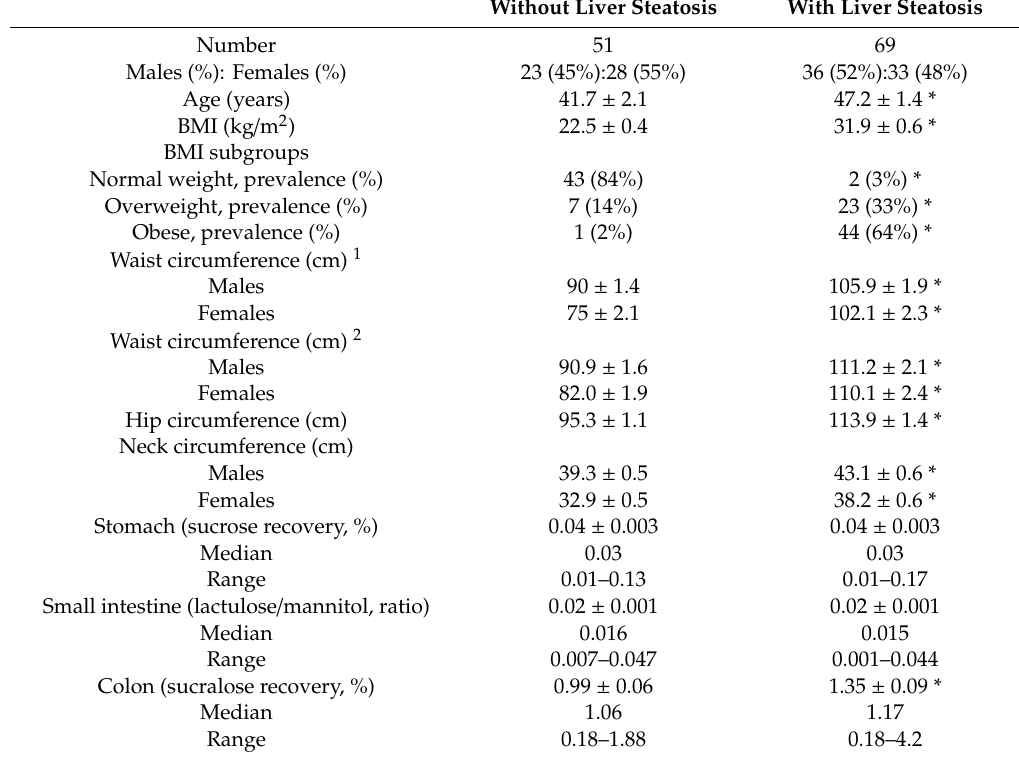
Figure 6. Correlation between sucralose recovery and waist, neck, and hip circumferences in: All subjects ( A ) and in females ( B ). Table 3. Anthropometric features according to liver steatosis and intestinal